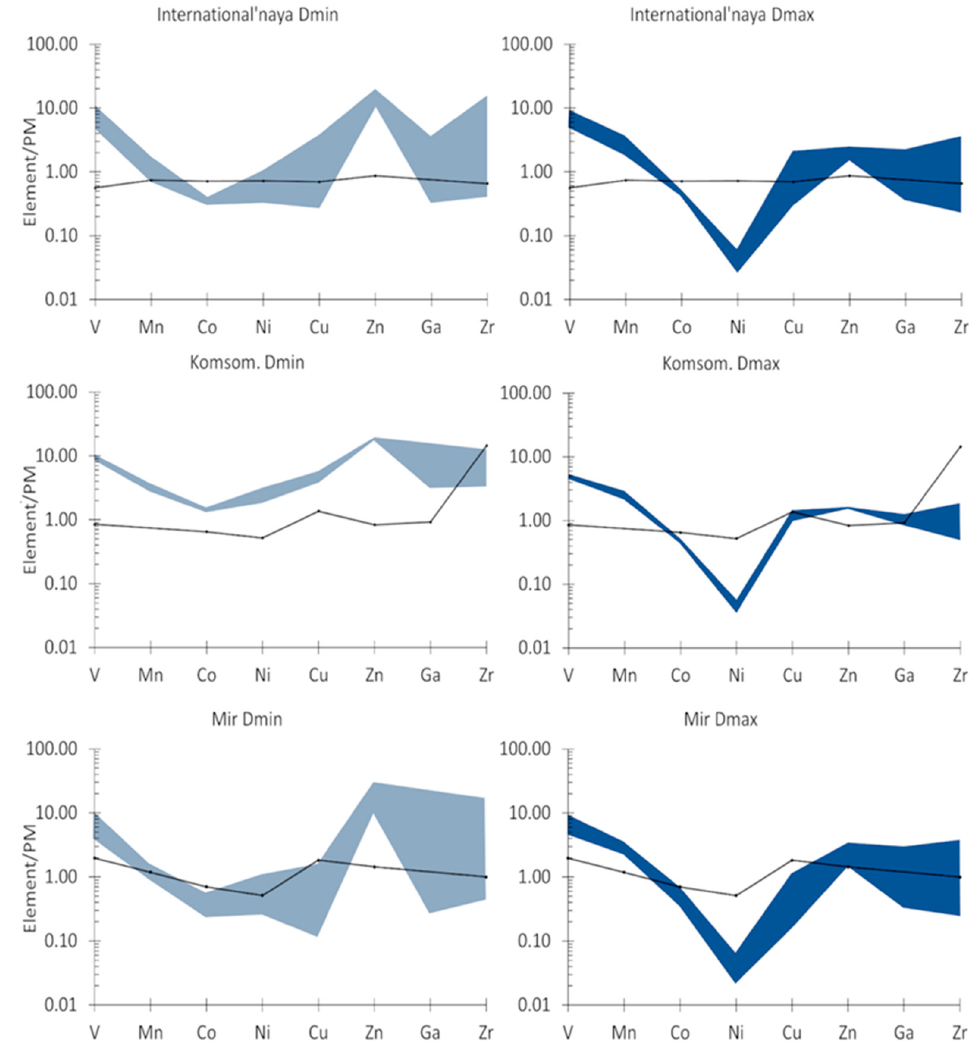
Figure 6. Modelled melts in equilibrium with Chr spinels. Light and dark blue spidergrams show the modelled melt compositions obtained with the minimum and maximum D sp/melt , respectively (see Table 1). Black lines represent the kimberlite whole rock compositions from [34]. Data normalised to Primitive Mantle from [38].